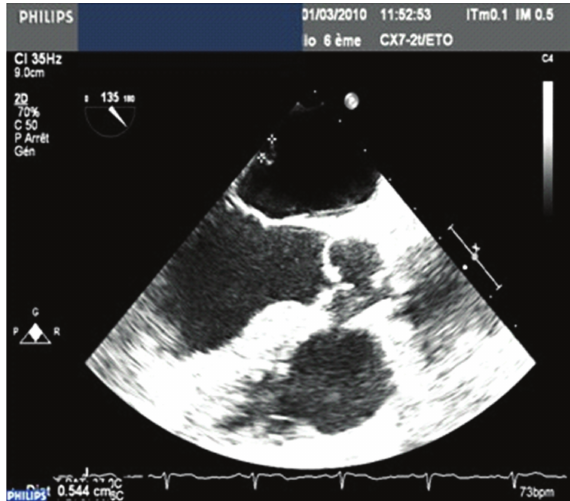
Figure 2: Measurement of two masses in left